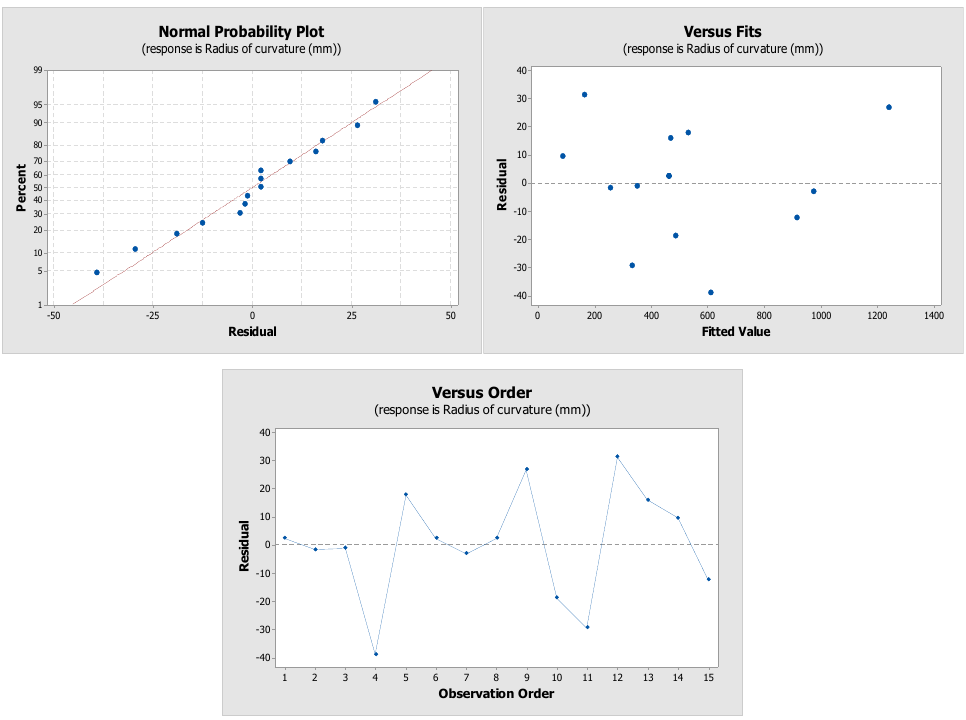
Figure 2. Normal probability plots for radius of curvature.